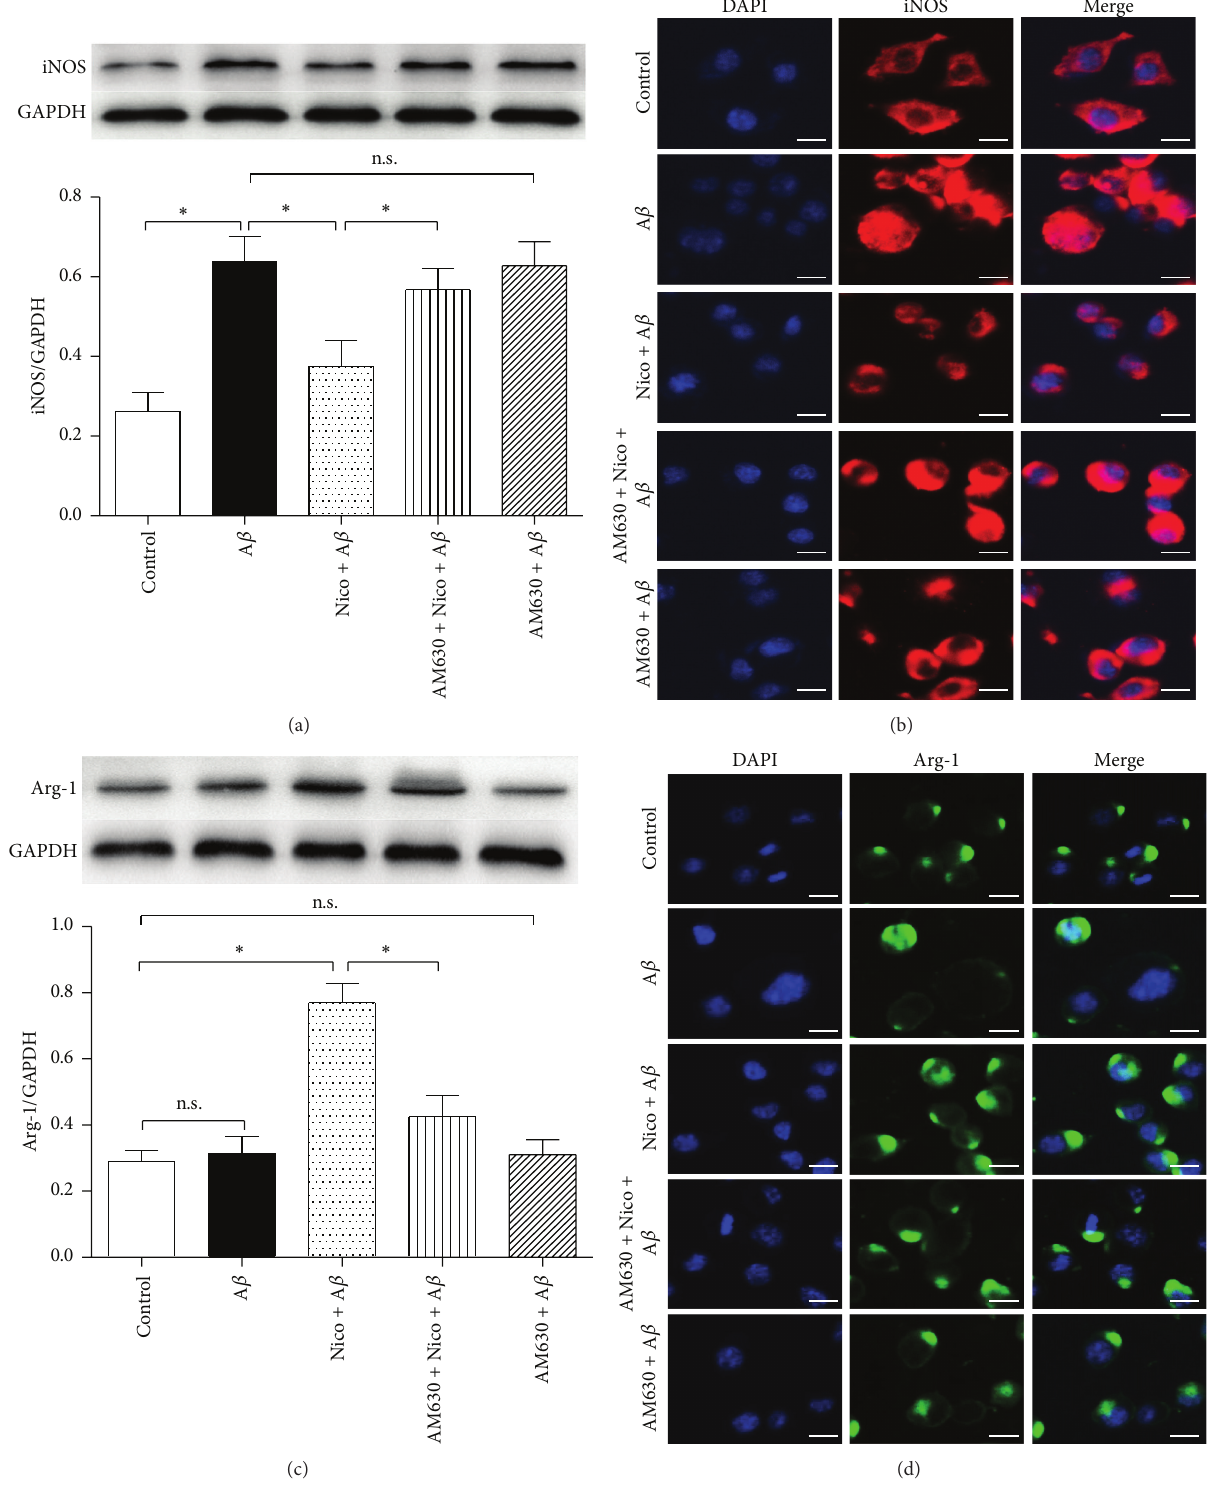
Figure 3: CB2 receptor antagonist reversed nicotine-induced effects on iNOS and Arg-1 protein expressions. The microglial cells were divided into five groups: control: cells cultured in drug-free medium; A 𝛽 : cells cultured in the medium containing 5 𝜇 M A 𝛽 ; nicotine (Nico) + A 𝛽 : cells cultured in the medium containing 10 𝜇 M nicotine and 5 𝜇 M A 𝛽 ; AM630 + Nico + A 𝛽 : cells cultured in the medium containing 10 𝜇 M CB2 antagonist AM630, 10 𝜇 M nicotine, and 5 𝜇 M A 𝛽 ; AM630 + A 𝛽 : cells cultured in the medium containing 10 𝜇 M AM630 and 5 𝜇 M A 𝛽 . After an incubation of 24 h, western blot ( 𝑛 = 4 ) and immunocytochemistry were used to evaluate iNOS (a-b) and Arg-1 (c-d) expressions. Results are expressed as means ± SD, ∗ 𝑃 < 0.05 ; n.s.: no significance. Bar = 10 𝜇